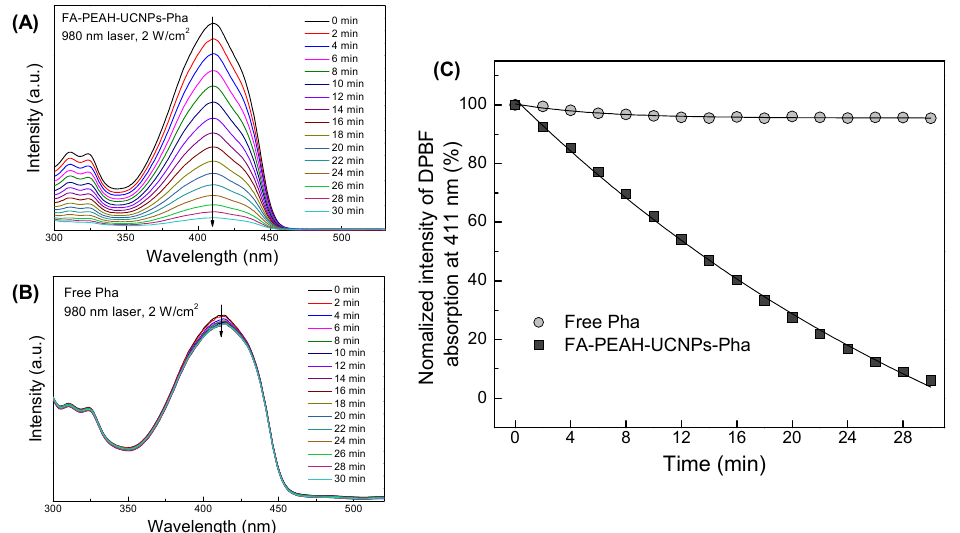
Figure 7. ( A ) The decrease in absorbance intensity of DPBF at 411 nm at different irradiation time of FA-PEAH-UCNPs-Pha, ( B ) the decrease in absorbance intensity of DPBF at 411 nm at different irradiation time of free Pha, and ( C ) singlet oxygen generation from free Pha and FA-PEAH-UCNPs-Pha detected by using DPBF as a function of 980 nm laser irradiation time.